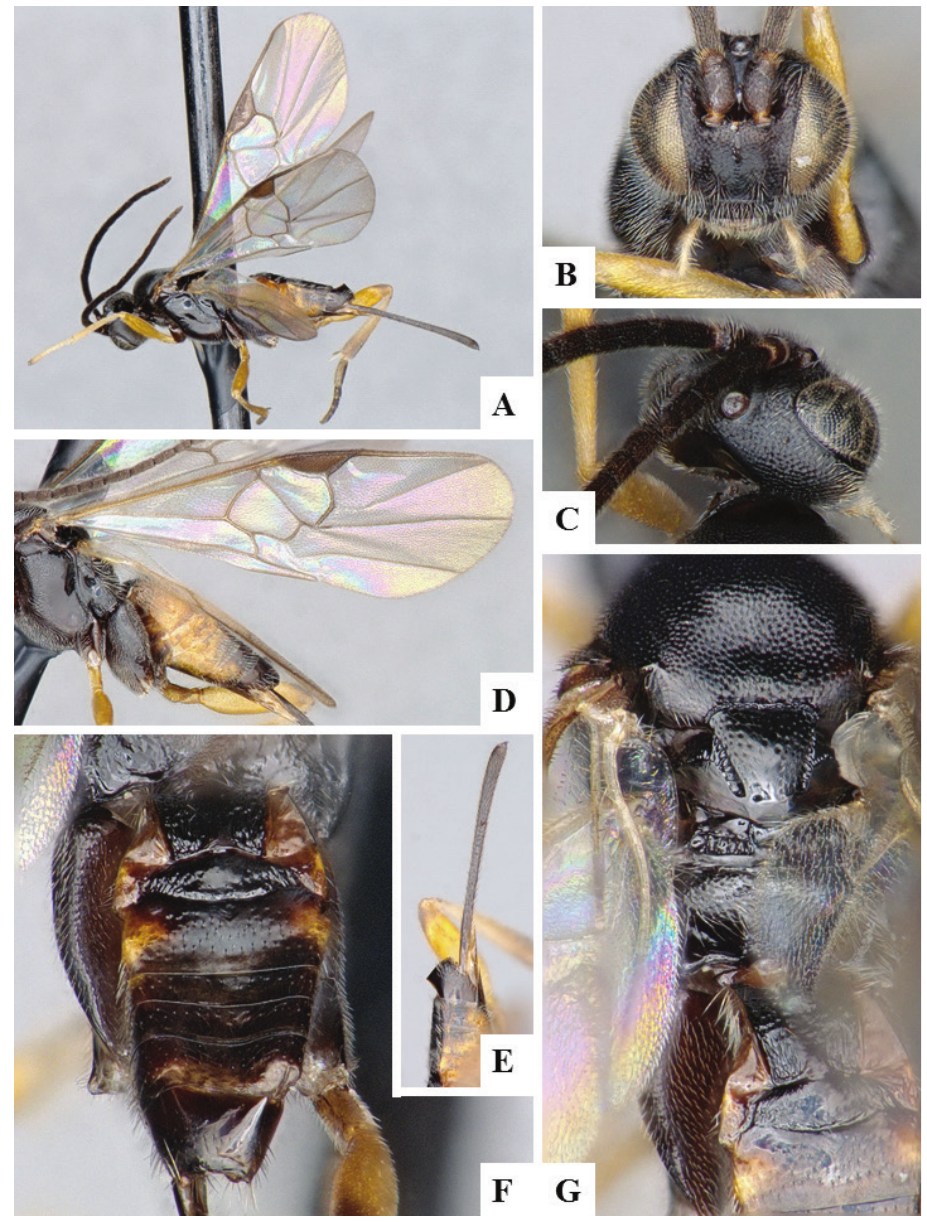
Figure 19. Dolichogenidea absona. A Habitus, lateral B Head, frontal C Head, frontal D Wings E Ovipositor sheaths F Metasoma, dorsal G Mesosoma,